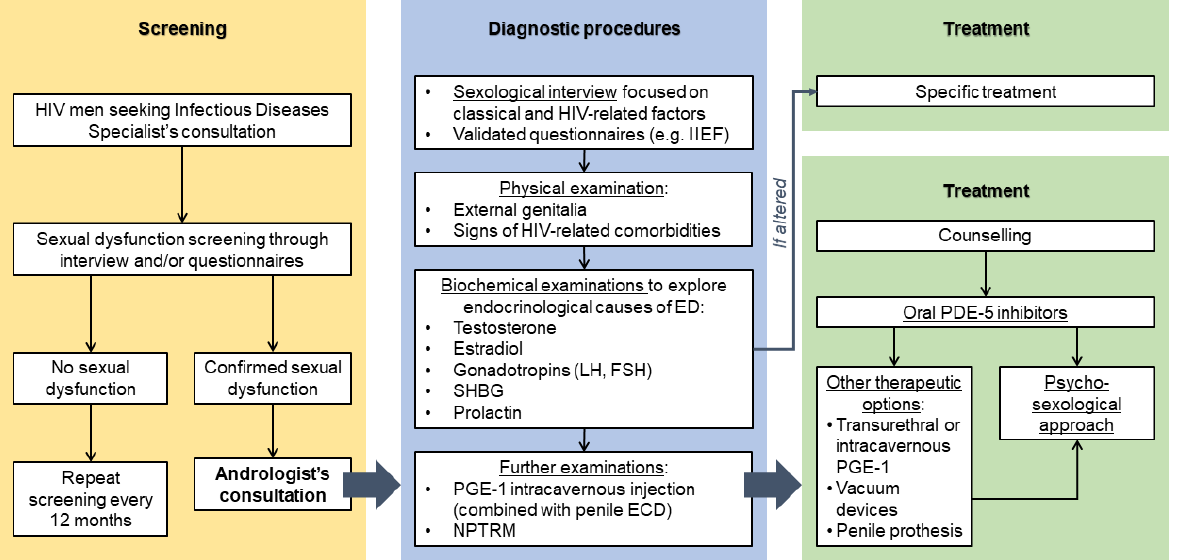
Figure 3. Diagnostic and subsequent therapeutic work-up to erectile dysfunction in HIV men. Abbreviations: IIEF, International Index of Erectile Function; ED, erectile dysfunction; LH, luteinizing hormone; FSH, follicle-stimulating hormone; SHBG, sex hormone-binding globulin; PGE-1, prostaglandin E1, ECD, eco-color-Doppler; NPTRM, nocturnal penile tumescence and rigidity monitoring; PDE-5, phosphodiesterase type 5.